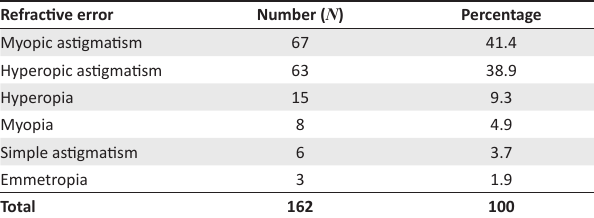
FIGURE 1: The percentages of ocular alignment conditions detected using the cover and Maddox rod TABLE 1: Refractive error findings.